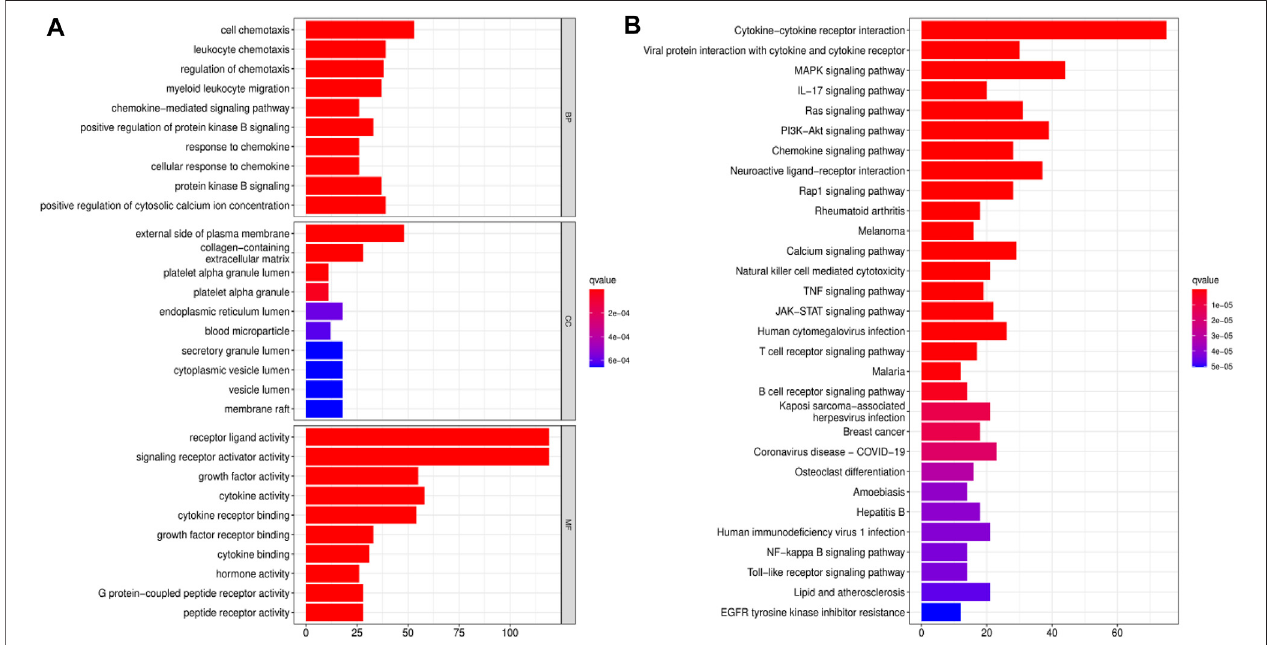
FIGURE 2 | Functional enrichment analyses for immune-related differentially expressed genes (DEGs). (A) Gene Ontology (GO) enrichment analysis for immune- related DEGs. (B) Kyoto Encyclopedia of Genes and Genomes (KEGG) pathway analysis for immune-related DEGs.